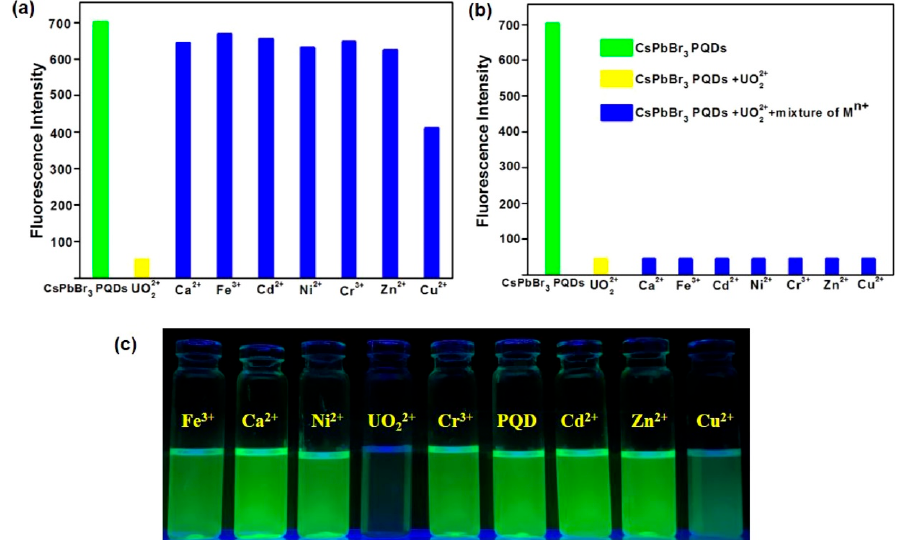
Figure 9. ( a ) Change in the PL of CsPbBr 3 PQDs upon the addition of various ions. ( b ) Effect of interfering cations with the absorption of bare CsPbBr 3 PQDs and CsPbBr 3 PQDs + UO 22+ complex ( c ) Digital photograph of colorimetric changes of the probe upon addition of various metal ions (reproduced with the permission from reference